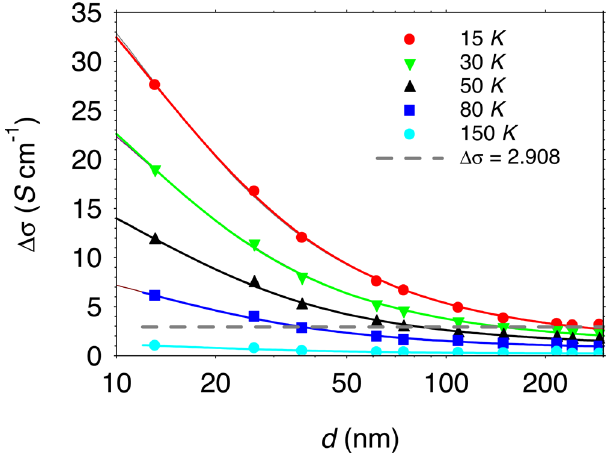
Fig. 4 Magnetoconductivity vs thickness at various temperatures. Solid symbols, experimental values of magnetoconductivity Δ σ ; solid lines, theoretical fi ts of symbols to Δ σ ( d ) = Δ σ U {1 + [ R NU β / d ][1 – exp( − d / β )]}. Red circles, 15 K; green triangles, 30 K; black triangles, 50 K; dark blue squares, 80 K; light blue circles, 150 K. Dashed line, Δ σ = 2.908 S cm − 1 , which is the theoretical maximum QMC for uniform disorder.